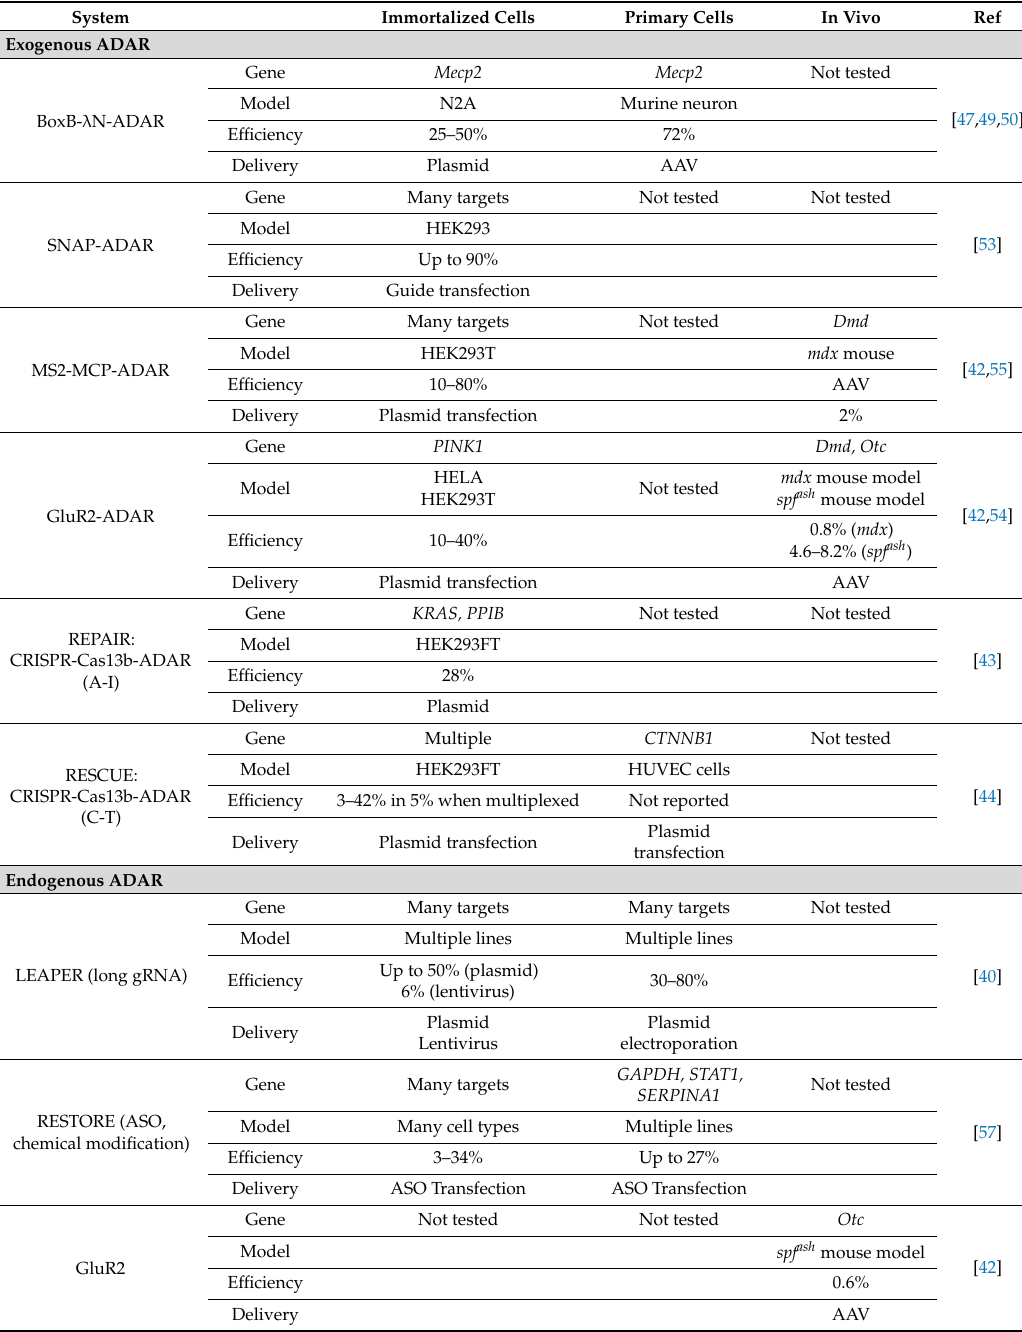
Table 1. Comparison of each RNA editing tools and their on-target e ffi ciencies for endogenous transcripts. Editing e ffi ciencies of reporter systems or over-expressed are not reported here. ADAR = adenosine deaminase acting on RNA; λ N = Lambda N protein; MCP = MS2 bacteriophage coat binding protein; REPAIR = RNA Editing for Programmable A to I Replacement; RESCUE RNA Editing for Specific C to U Exchange; LEAPER = Leveraging Endogenous ADAR for Programmable Editing of RNA; RESTORE: Recruiting Endogenous ADAR to Specific Transcripts for Oligonucleotide-mediated RNA Editing; AAV = adeno-associated